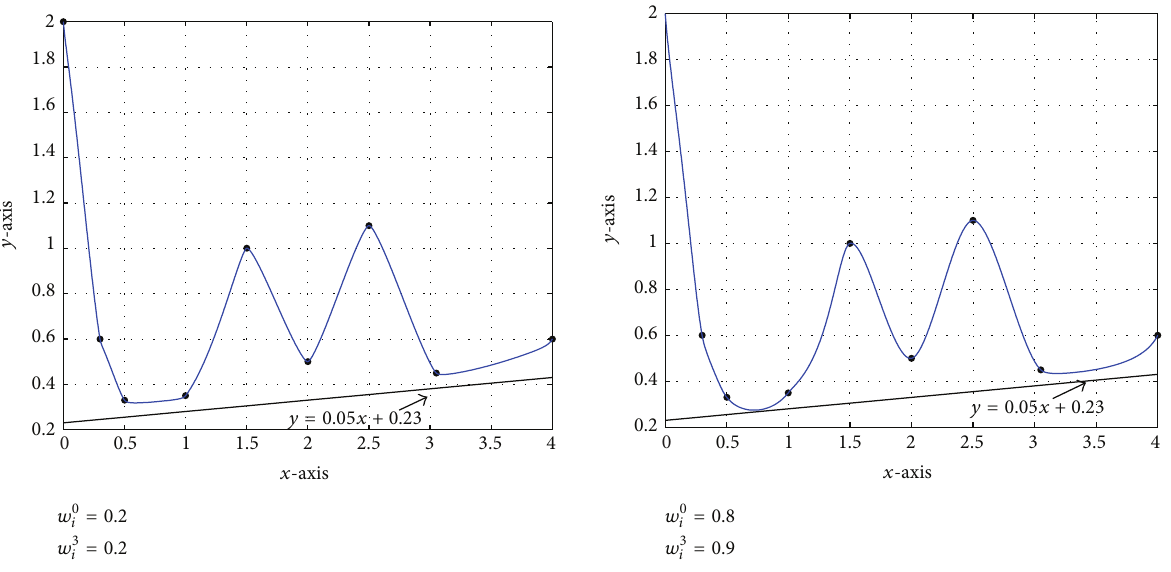
Figure 12: 𝐶 1 piecewise rational cubic trigonometric curve constrained by a given